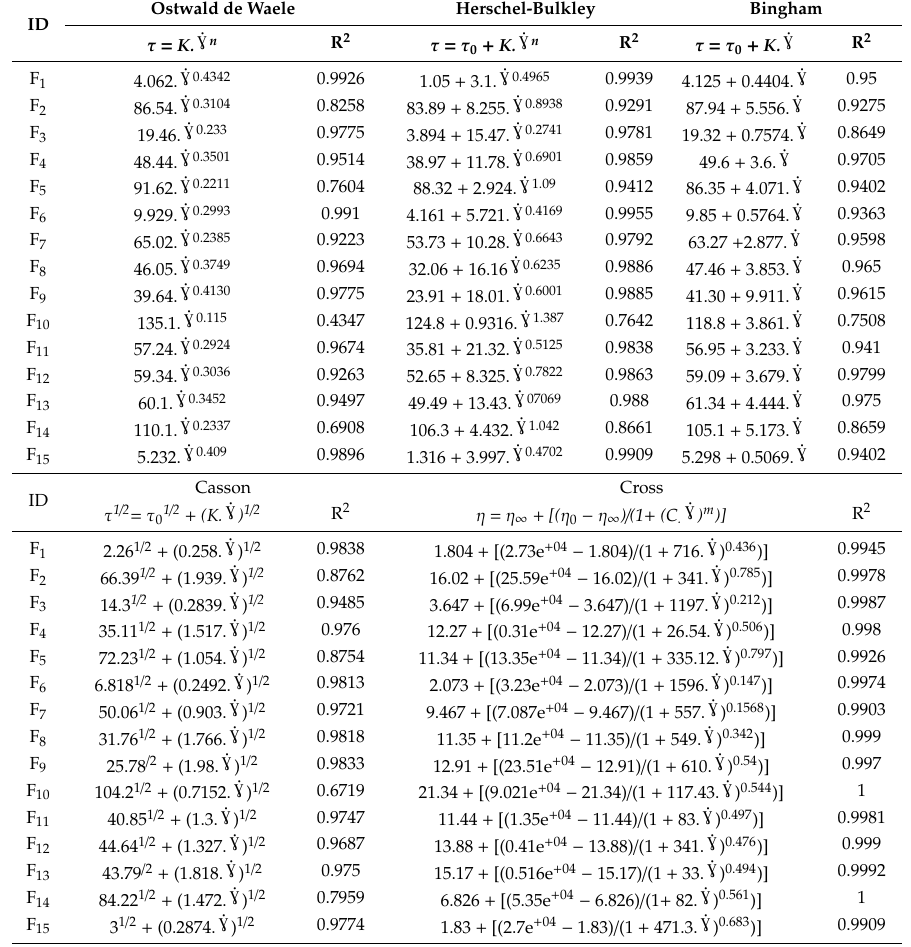
Table 8. E ff ect of independent variables on cream release profile. Regression coe ffi cients resulting from the application of Higuchi and Korsmeyer-Peppas mathematical models to the experimental release data. Data are expressed as mean ± SD (n =